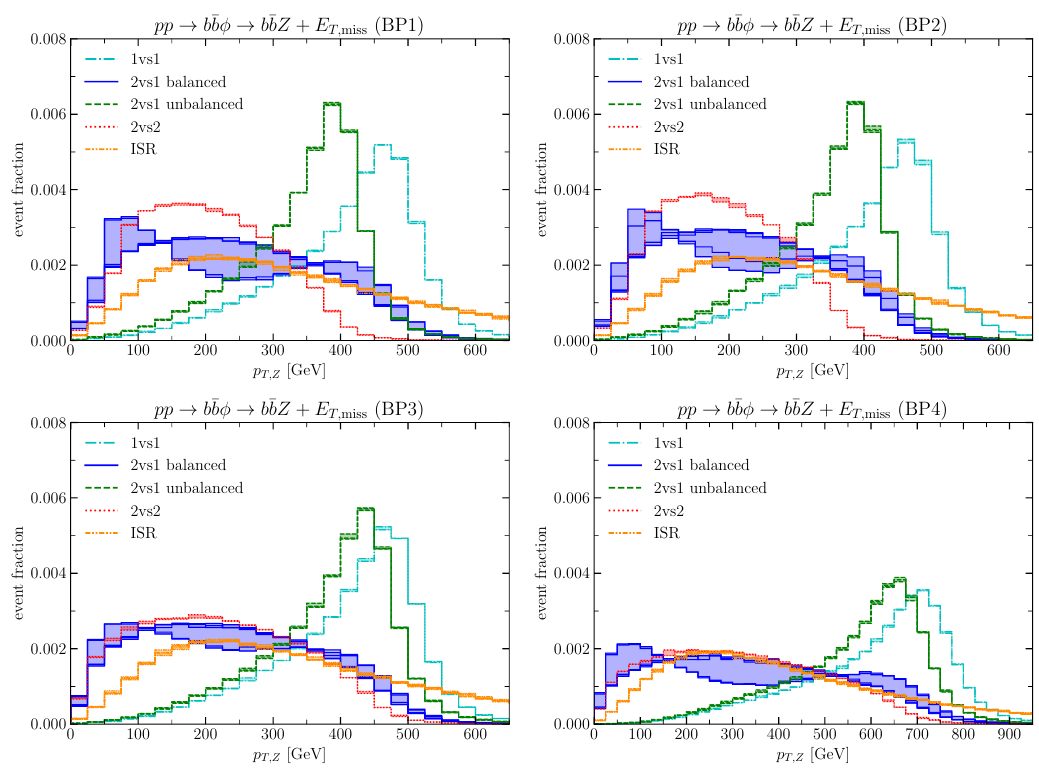
Figure 8. Mono- Z + E miss final state: transverse momentum distribution of the di-muon system T evaluated for BP1 (upper left panel), BP2 (upper right panel), BP3 (lower left panel), and BP4 (lower right panel). All different curves of the 1vs1 topology are contained in the turquoise band; the curves of the 2vs1 balanced topology in the dark blue band; the curves of the 2vs1 unbalanced topology in the green band; and, the curves of the 2vs2 topology in the red band. The ISR topology curve is shown in